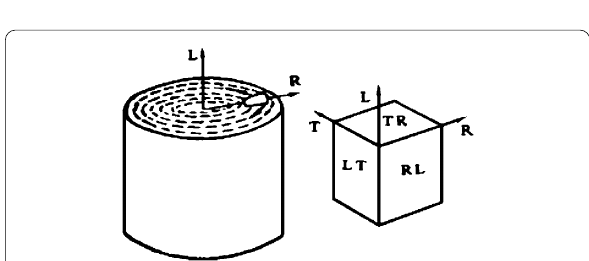
Fig. 14 Schematic diagram of wood orthogonal symmetry